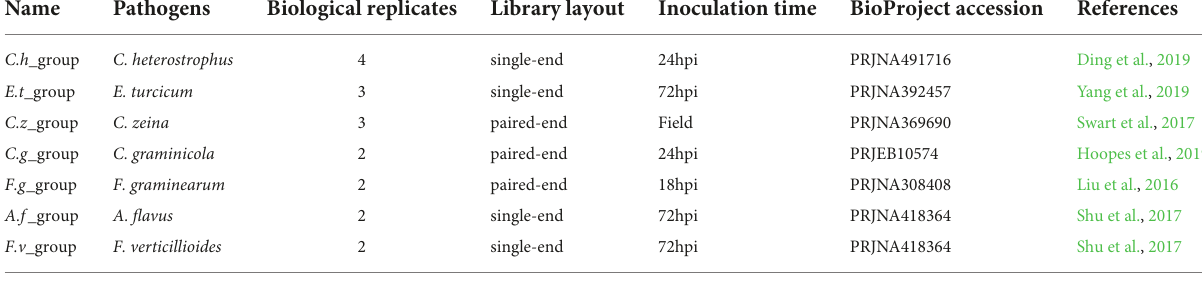
TABLE 1 Main features of RNA-seq datasets used for meta-analysis.